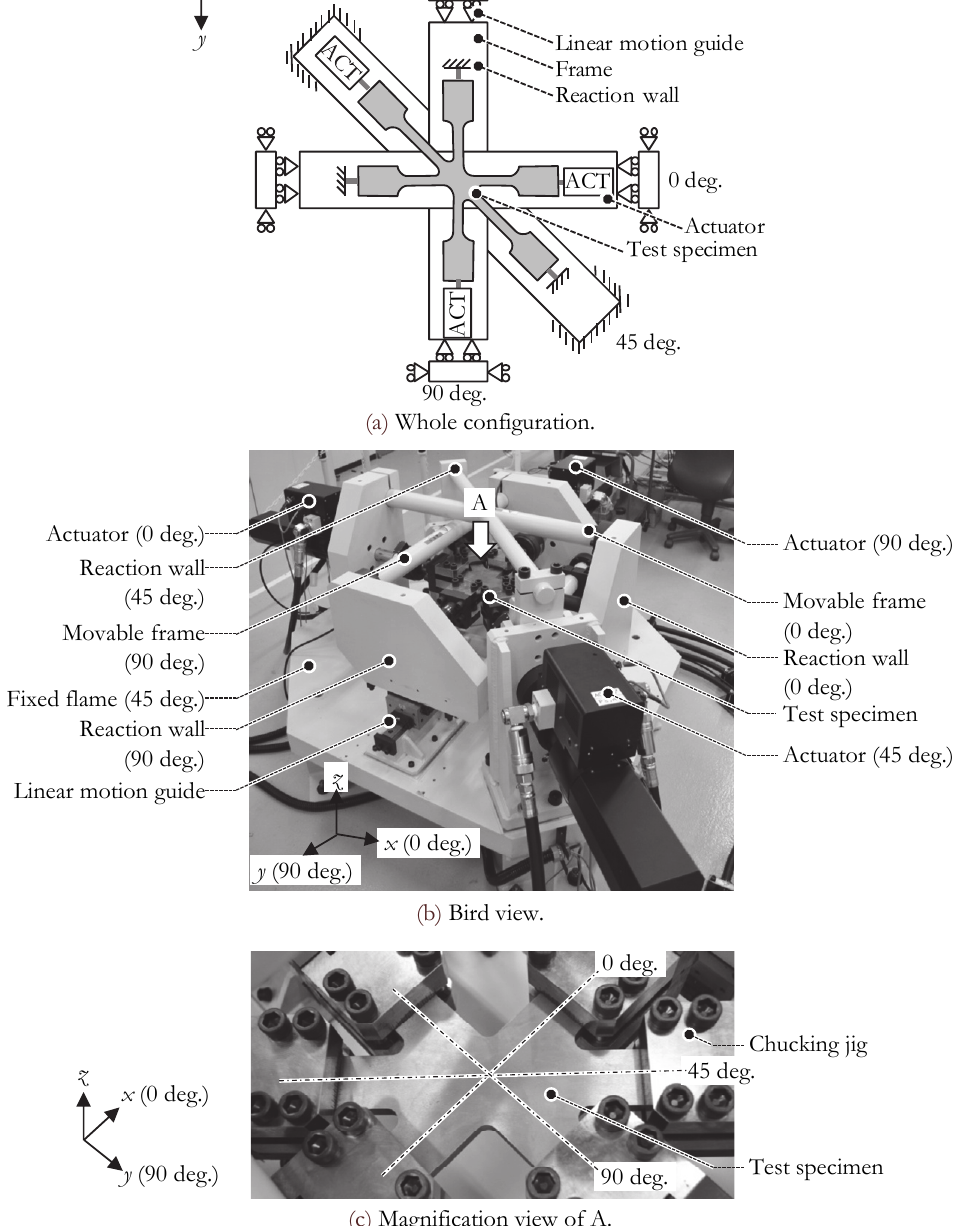
Figure 2: Planar tri-axial fatigue testing